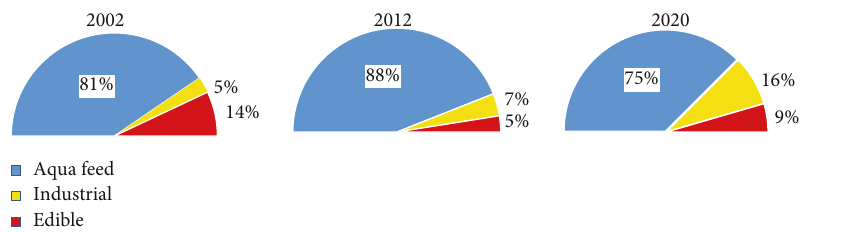
Figure 3: Global estimated use of fi sh oil in three di ff erent sectors (aquaculture feeds, industrial, and edible) in 2002, 2012, and 2020 [15, 52,